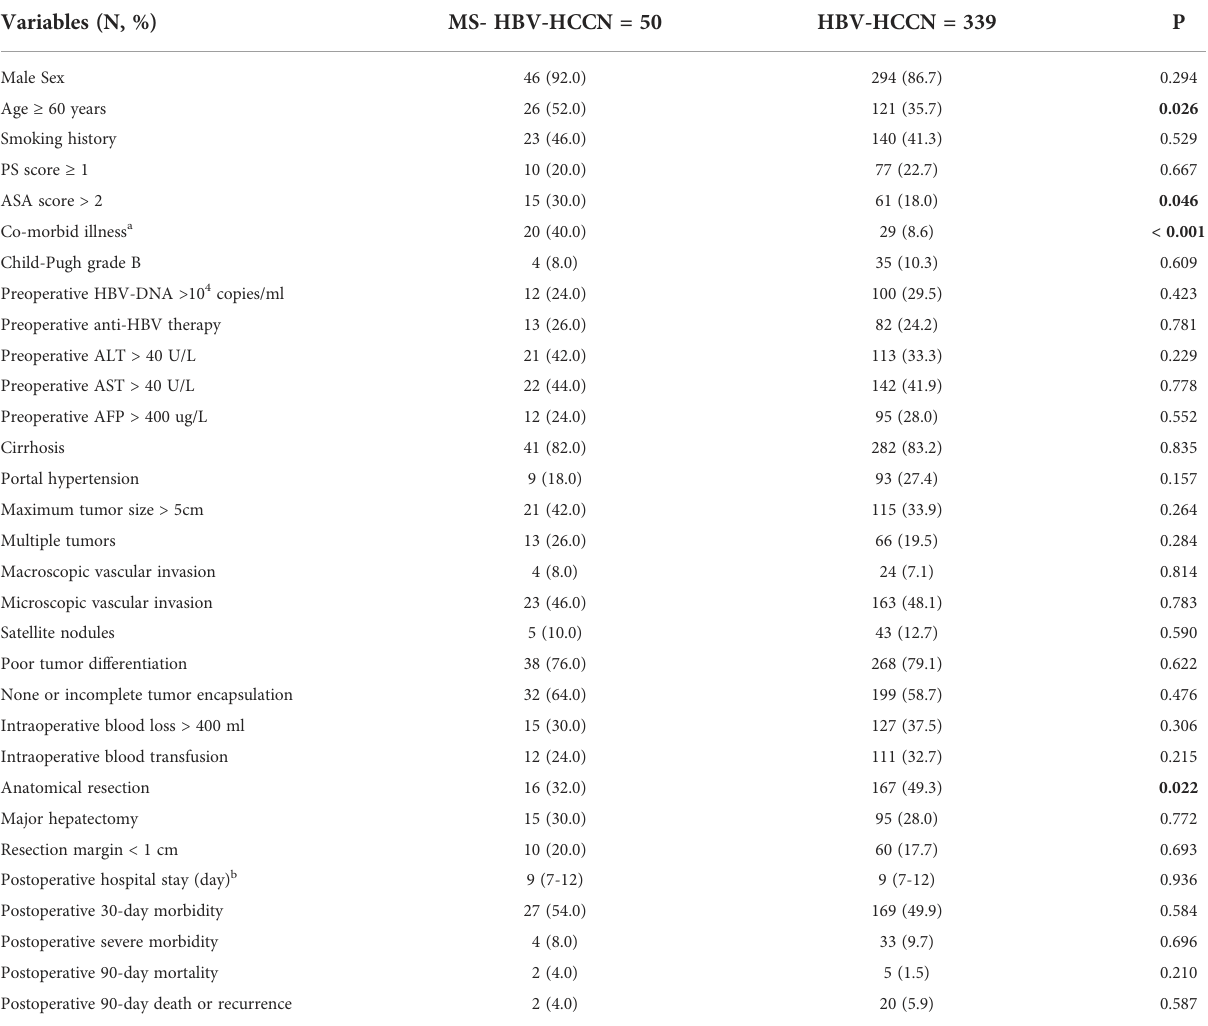
TABLE 1 Comparison of clinical and pathological characteristics and short-term outcomes between the study groups in the whole study population. Variables (N,